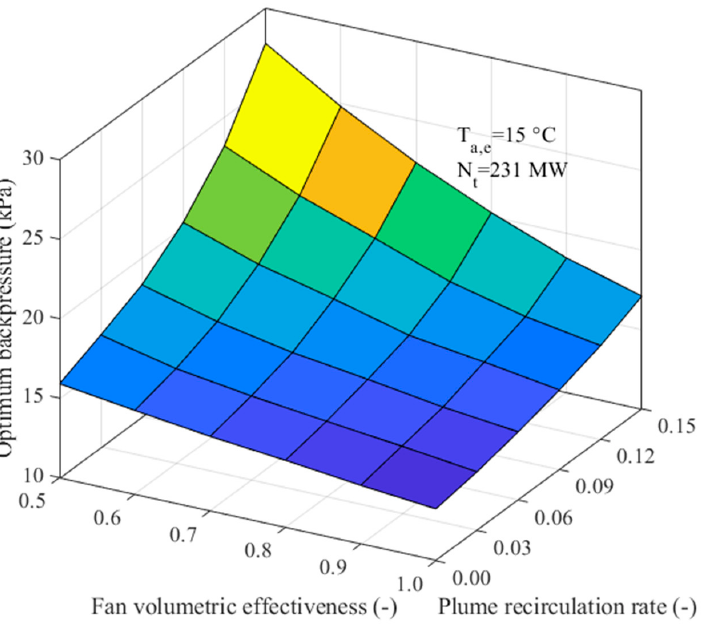
Figure 9. Optimum backpressure at different plume recirculation rates and fan volumetric effective- ness.